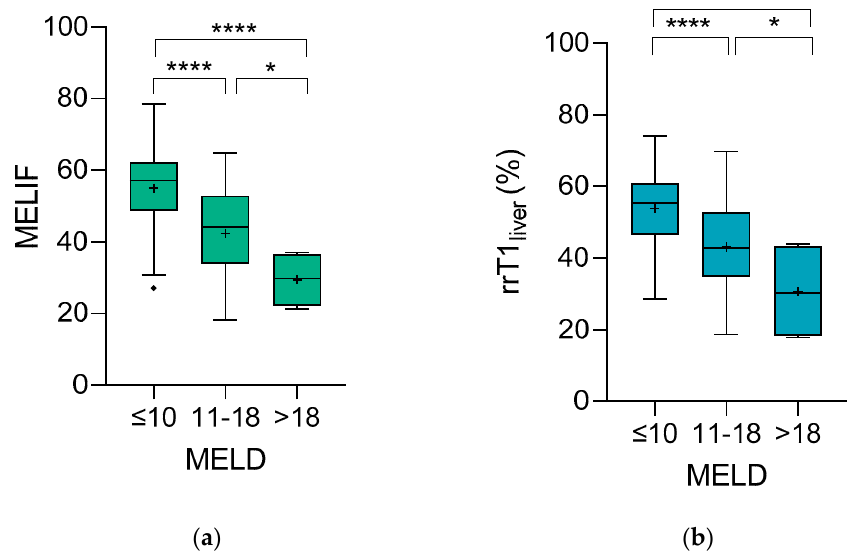
Figure 2. Pairwise comparisons of the MELD groups for ( a ) the MELIF score and ( b ) rrT1 liver . The boxplots were made according to Tukey’s test. The + represents the mean value. Using the unpaired t test, pairwise differences were calculated. **** ≤ 0.0001; * ≤ 0.05. MELD ≤ 10, N = 132; MELD 11–18, N = 59; MELD > 18, N = 4.